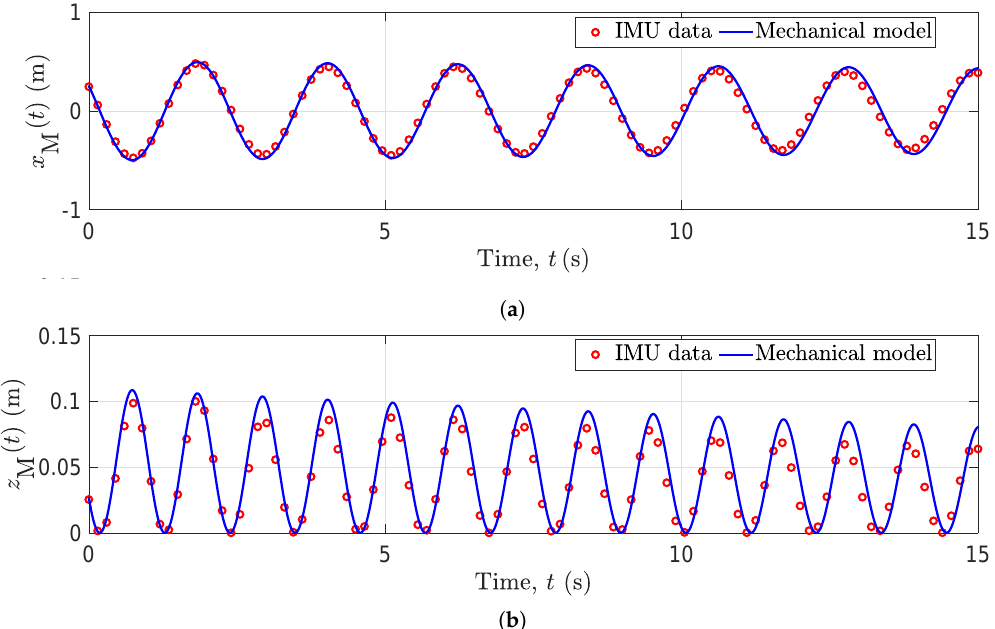
Figure 3. Trajectories of the mechanical model and measured IMU data in ( a ) horizontal direction x M ( t ) and ( b ) vertical direction z M ( t )